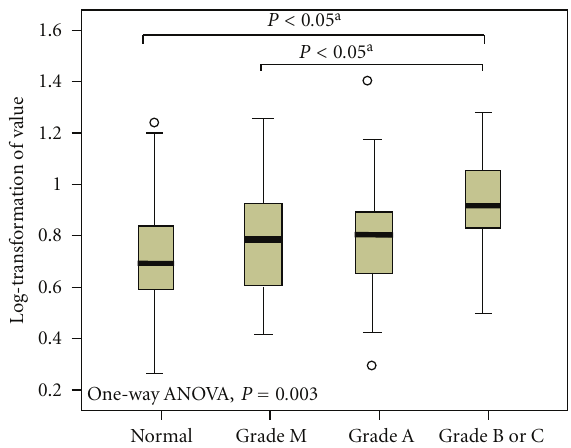
Figure 1: Distribution of geometric means of FDG uptake (SUVmax) and standard deviation according to the grades of severity of esophagitis. One-way ANOVA and post-hoc comparison with Bonferroni correction compared mean values of ln SUVmax (log-transformation SUVmax) among the grades of esophagitis